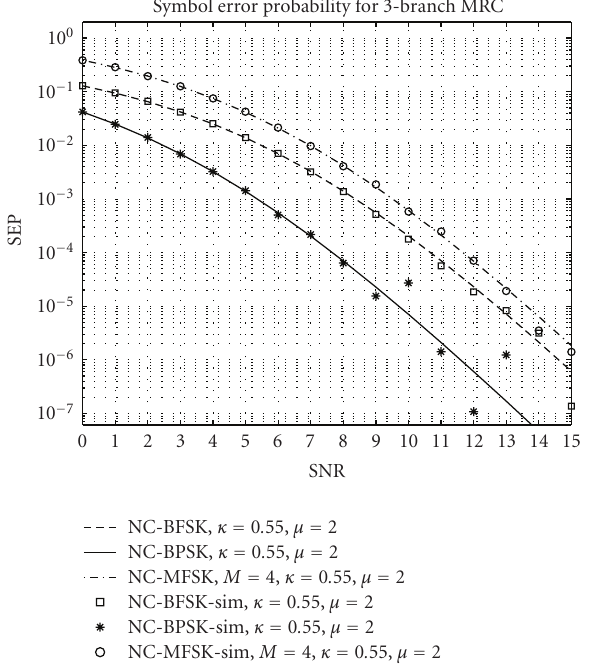
Figure 13: BEP/SEP for noncoherent detection, 3-branch diversity.